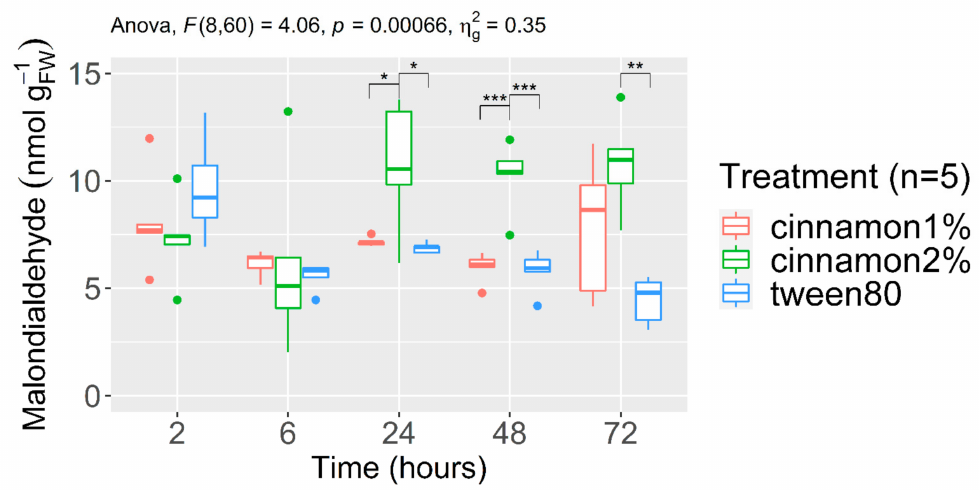
Figure 2. Effect of C. cassia EO (CEO) (1 and 2% v / v ) and tween 80 application on malondialde- hyde (MDA) leaf content (ng/g) over time ( n = 5). Star on boxplot indicates significantly different